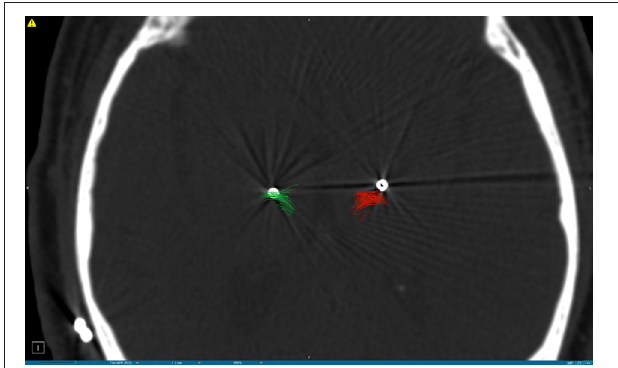
FIGURE 2 | Postoperative CT scan demonstrating deep brain stimulation electrodes placed in the Vim nucleus of the thalamus for the treatment of tremor. DTI tractography of the dentatorubrothalamic tract (DRT) is superimposed on the CT scan, and is indicated in green on the left side (corresponding to the radiographic right side of the brain) and in red on the right side (radiographic left side of the brain). Note the position of the DBS lead on the right side of the brain lies within the DRT and provided symptomatic relief, whereas the DBS lead on the left side of the brain is located outside the DRT and did not provide symptomatic